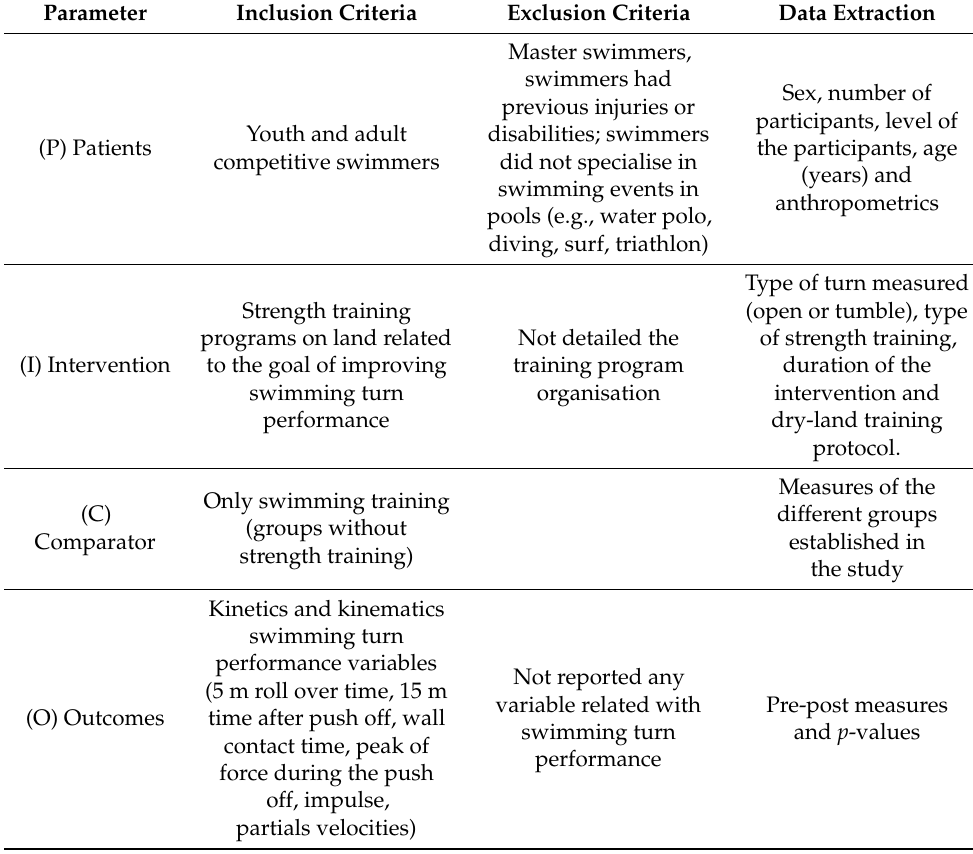
Table 1. PICO criteria used to develop the research question and include and exclude